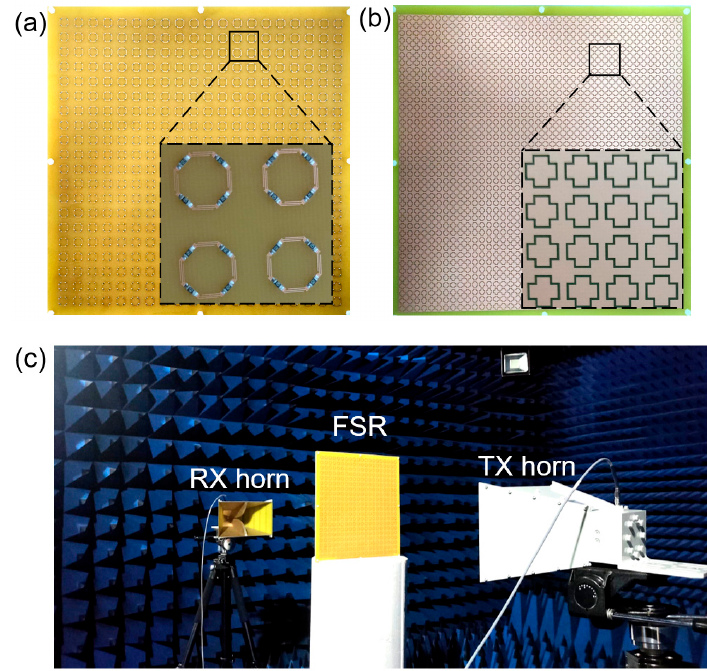
Figure 9. Fabricated sample and experimental system. ( a ) Lossy layer. ( b ) Bandpass layer. ( c ) Experimental system.